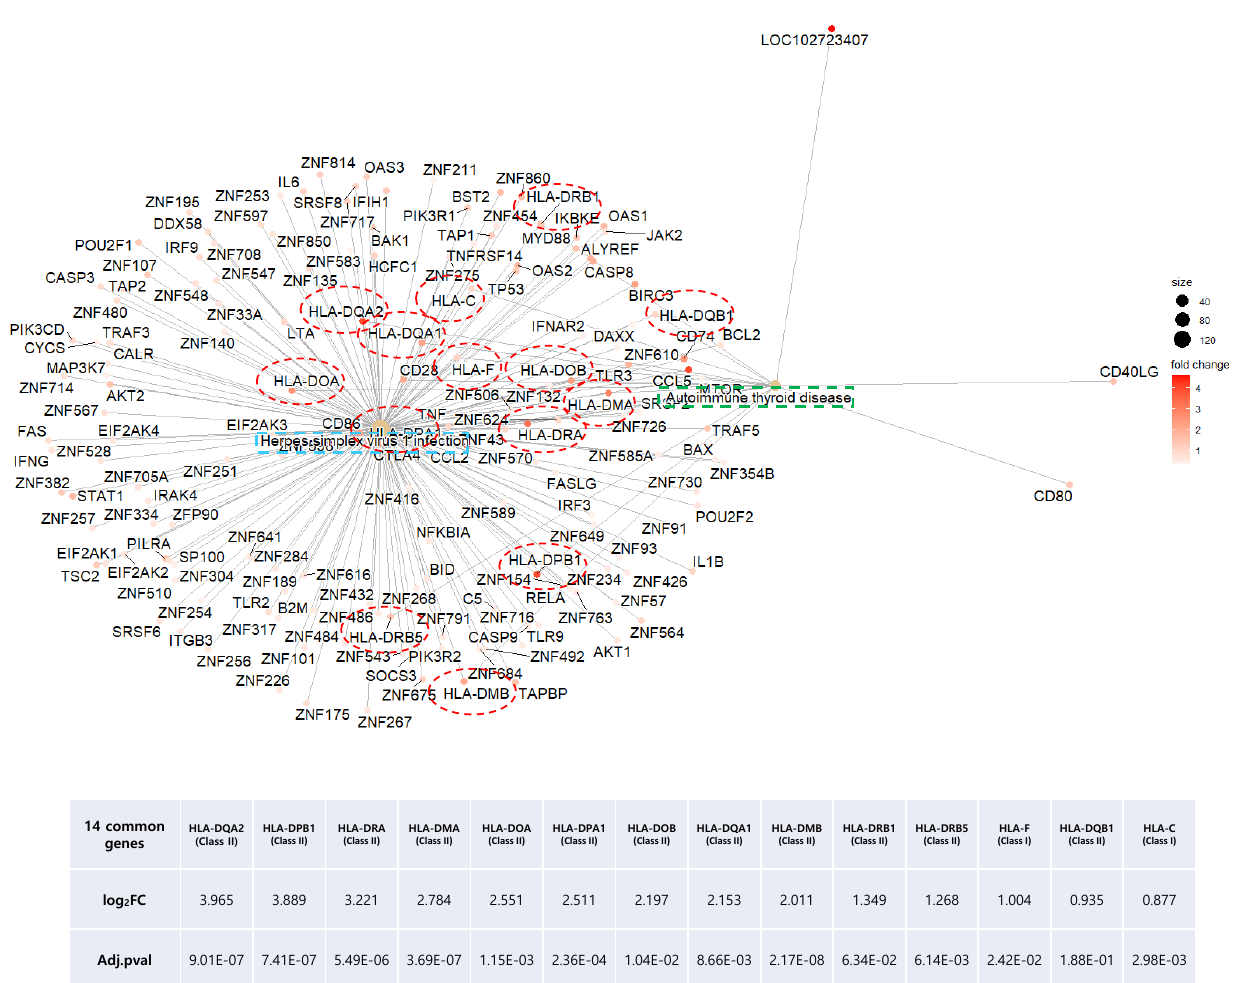
Figure 7. Distribution of overlapping DEGs between the herpes simplex virus infection and au- toimmune thyroid disease KEGG pathways of the HT group. Green and blue square boxes indicate pathway names, and the 14 red circles denote overlapping DEGs between the two